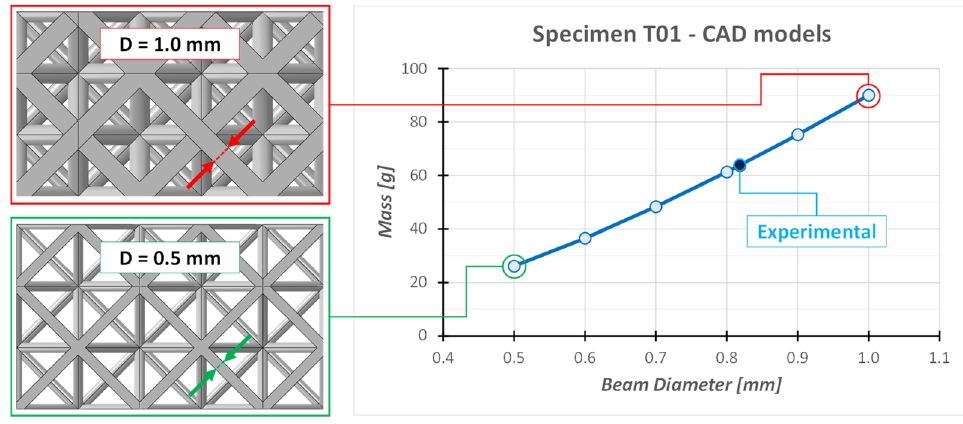
Figure 7. Truss’s diameter vs. specimen mass and section view of the upper and lower limits.